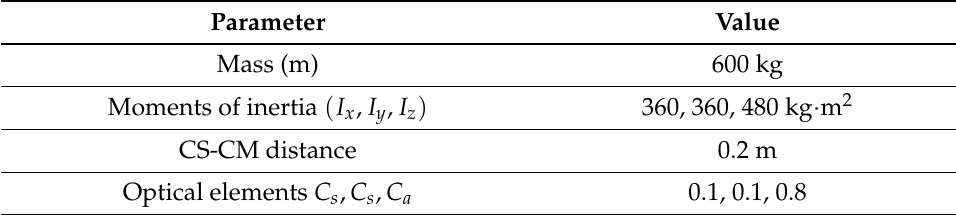
Table 2. Spacecraft parameters.